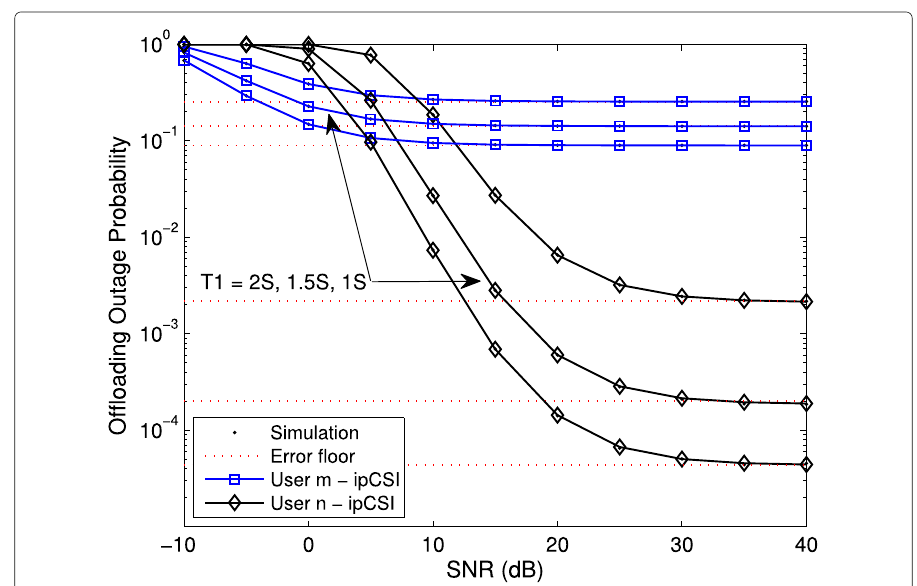
Fig. 6 Offloading outage probability versus SNR with various values of offloading time